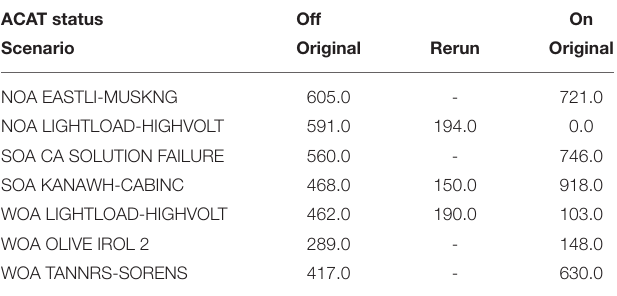
TABLE 4 | Completion times for each scenario.